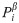
Probability of interactions of type β, Piβ as a function of the distance r between players.An approximate power law exponent for communication events is found to be ∼ −1.3 (black line).